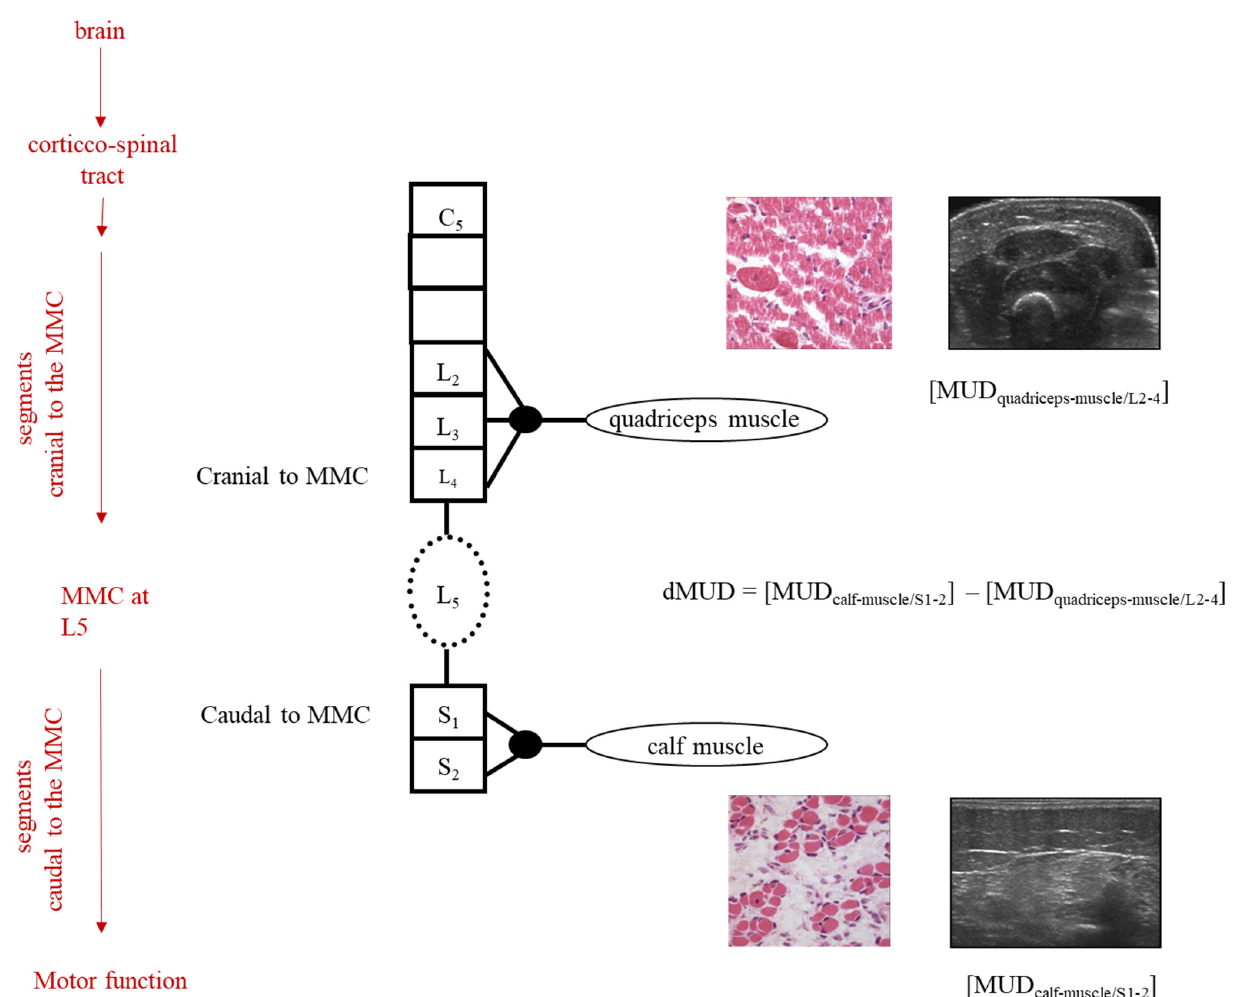
Figure 1. Schematic illustration of dMUD calculation in case of an MMC at spinal segment L5. On the left, the red arrows represent the influences on the neurological examination of the child. The black column represents the segmental innervation of the spinal cord, cranial-, and caudal to the MMC. In the case of an MMC at L5, the quadriceps muscle (innervation L2-4) is innervated by motor neurons originating cranial to the MMC and the calf muscle by motor neurons originating caudal to the MMC. By intra-individual subtraction of the MUD value caudal to the MMC minus the MUD value cranial to the MMC, the dMUD-outcome reflects the effect of the 2nd hit of damage on the muscle caudal to the MMC (i.e., the calf muscle). In children with an MMC at higher levels (i.e., at thoracic and/or high lumbar levels), dMUD values can be similarly calculated using the Biceps muscle (innervation C5) instead of the quadriceps muscle.